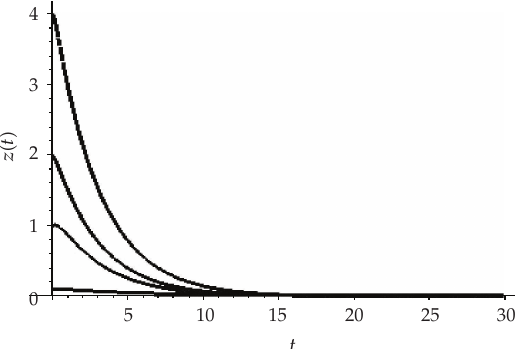
Figure 3: Dynamic behaviors of the third component z (cid:3) t (cid:4) of the solution (cid:3) x (cid:3) t (cid:4) ,y (cid:3) t (cid:4) ,z (cid:3) t (cid:4)(cid:4) T to system (cid:3) 3.1 (cid:4) with the initial condition (cid:3) 0 . 1 , 0 . 1 , 0 . 1 (cid:4) T , (cid:3) 1 , 1 , 1 (cid:4) T , (cid:3) 2 , 3 , 4 (cid:4) T , and (cid:3) 0 . 6 , 1 , 2 (cid:4) T , respectively.